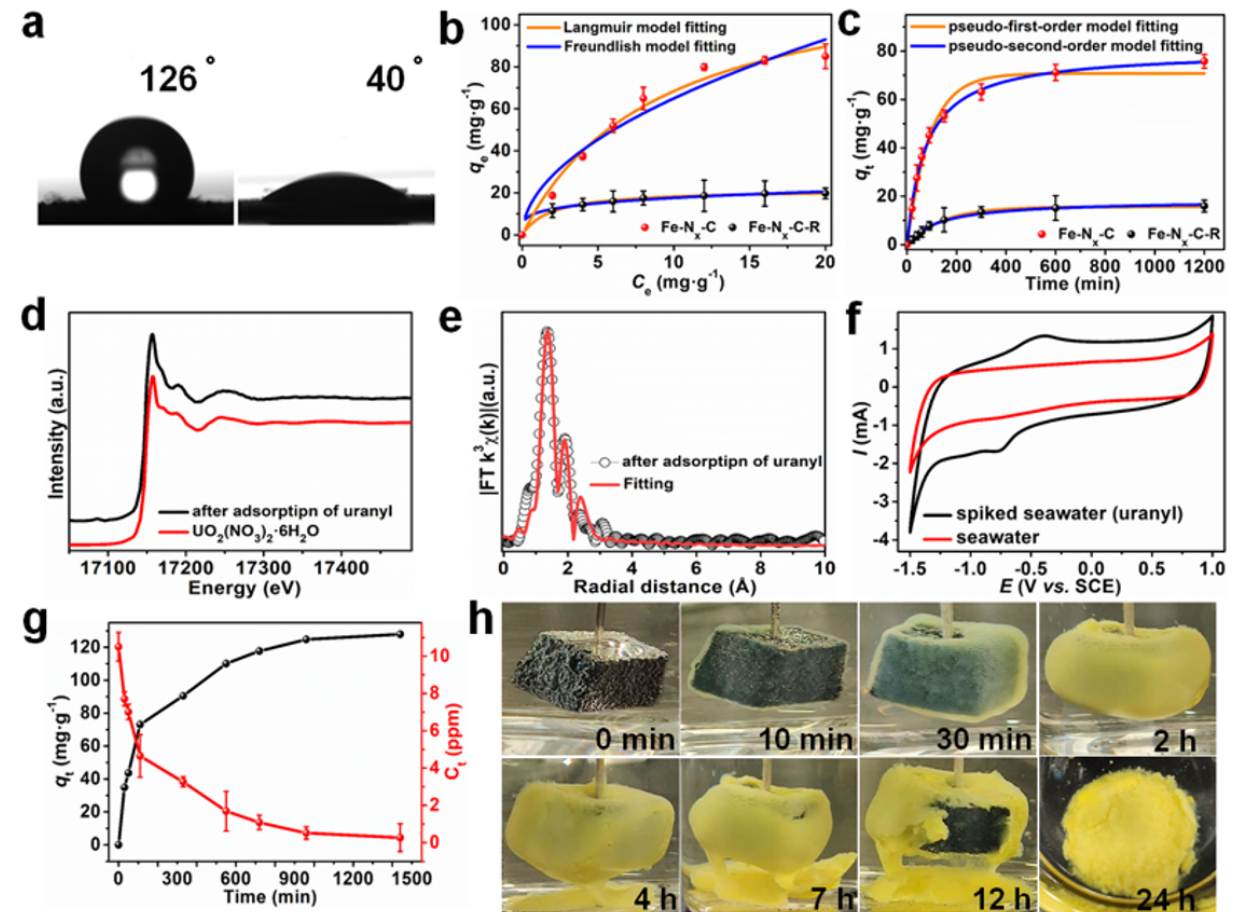
Figure 6. ( a ) Contact angles for deionized water on pressed pellets of Fe-N x -C (left) and Fe-N x -C-R (right), ( b ) Equilibrium adsorption isotherms for uranyl ion adsorption on different materials at a fixed material-to-solution ratio of 0.1 mg·mL − 1 in uranyl-spiked seawater (from 0 to 20 ppm), ( c ) Uranyl ion adsorption kinetics on different materials at an initial UO 22+ concentration of 10 ppm in uranyl − spiked seawater, ( d ) U L III -edge XANES spectra for Fe-N x -C-R after adsorption of uranyl, and UO 2 (NO 3 ) 2 ·6H 2 O, ( e ) U L III -edge EXAFS R-space and corresponding fitting curves for Fe-N x -C-R after adsorption of uranyl, ( f ) Cyclic voltammograms for uranyl-spiked seawater and natural seawater, ( g ) Uranium extraction from spiked seawater with initial uranium concentrations of ~10 ppm, using Fe-N x -C-R as an adsorbent − electrocatalyst, ( h ) Photographs of the Fe-N x -C-R electrode in spiked seawater (initial uranium concentration of ~1000 ppm) during electrocatalytic extraction [46], Copyright 2021 John Wiley and Sons.